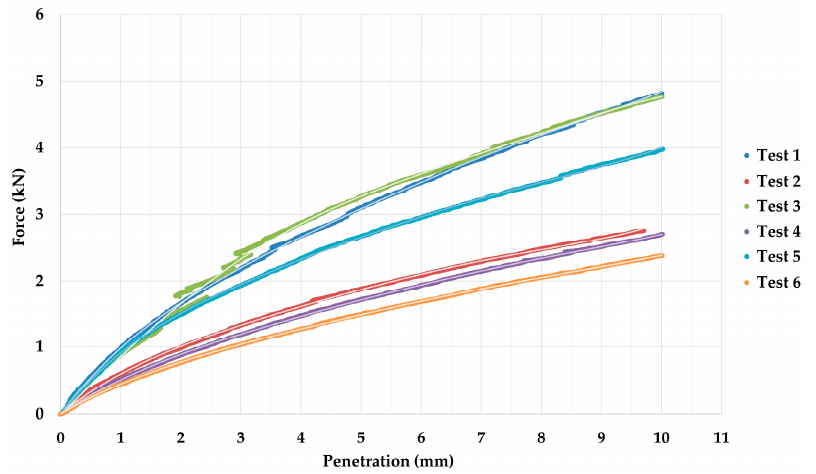
Figure 6. Force–penetration curve for each test.